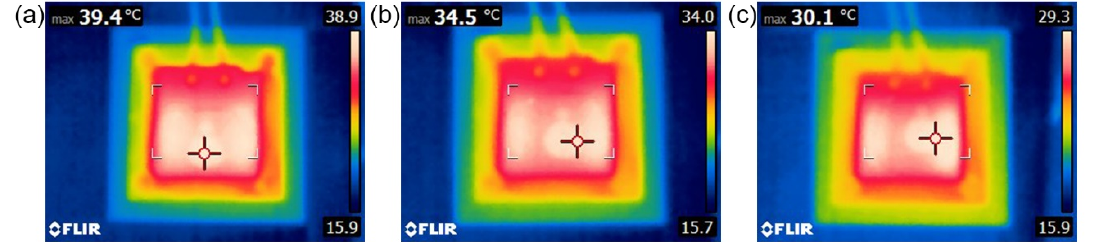
Figure 12. Infrared thermal images of the test system with different CF–rubber composites. ( a ) Sample—0 T; ( b ) Sample—5 T; ( c ) Sample—9 T.